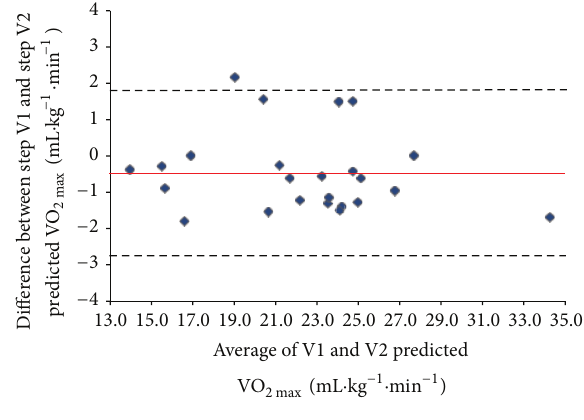
̇ Figure 3: Bland-Altman plot of VO 2 max predicted by the Siconolfi step test on visit 1 and visit 2. The mean bias is represented by the solid line and the 95% limits of agreement are represented by the dashed